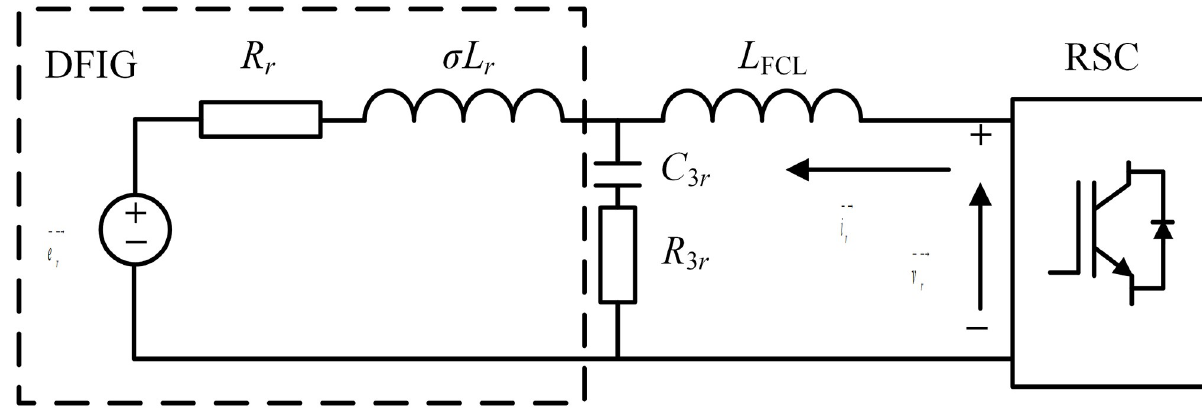
Fig 5. Equivalent circuit analysis of the RSC with the